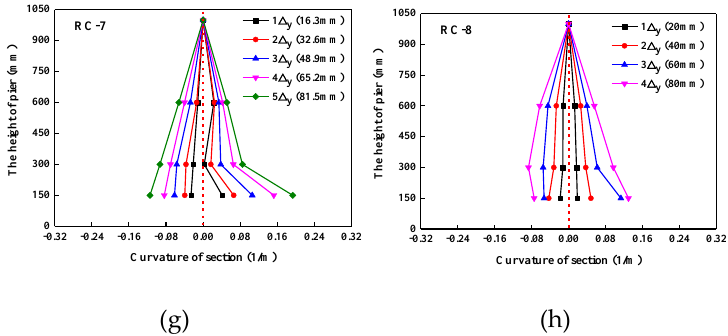
Figure 9. Curvature distributions along with the height of the pier. ( a ) PP-ECC-1; ( b ) PP-ECC-2; ( c ) PP-ECC-3; ( d ) PP-ECC-4; ( e ) PP-ECC-5; ( f ) PP-ECC-6; (g) RC-7; (h) RC-8.